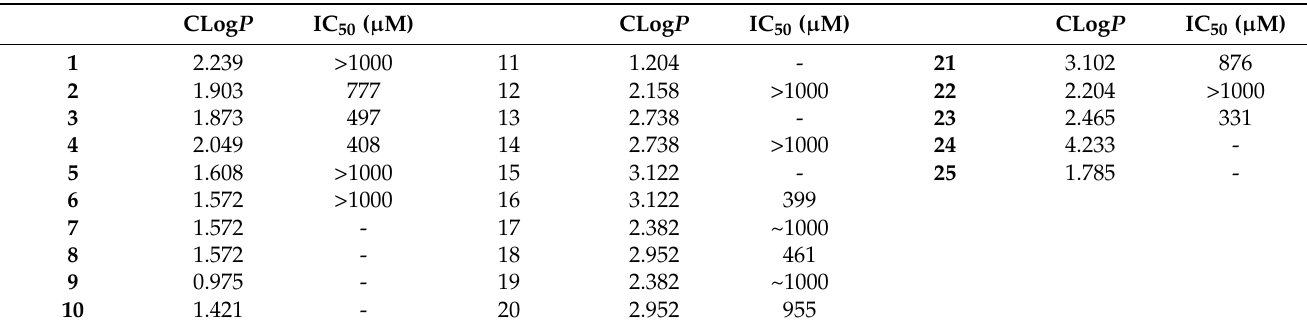
Figure 3. Photographs showing Cuscuta campestris seedlings treated with ( A ) a negative control or 1 mM treatments of ( B ) trans -cinnamic acid ( 1 ), ( C ) hydrocinnamic acid ( 2 ), and ( D ) trans -4-bromocinnamic acid ( 21 ). Table 1. Calculated CLog P and IC 50 ( µ M) values of compounds 1 – 25 : ~1000, inhibition was close to 50% at the highest tested concentration; >1000, the compound did not induce 50% inhibition at the highest concentration tested but activity was significant; <250, the IC 50 was lower than the lowest tested